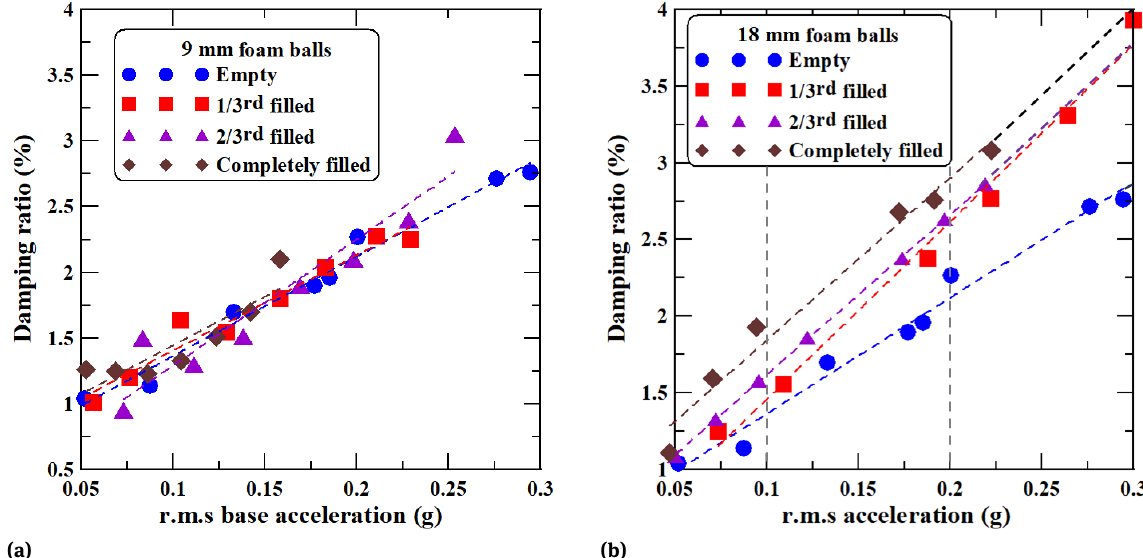
Figure 10: Damping ratio of empty and foam filled tubes with (a) 9 mm and (b) 18 mm diameter foam balls for varying excitation level